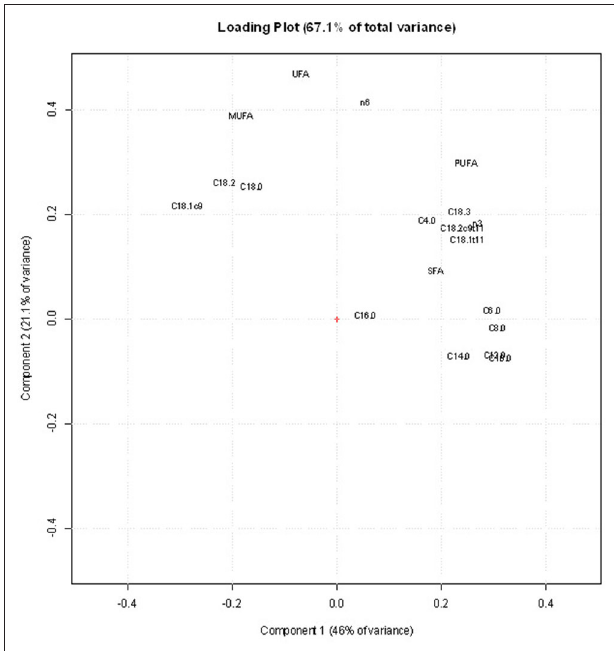
FIGURE 4 | Loading plot of the principal component analysis (PCA) obtained using the fatty acid (FA) profile data set.